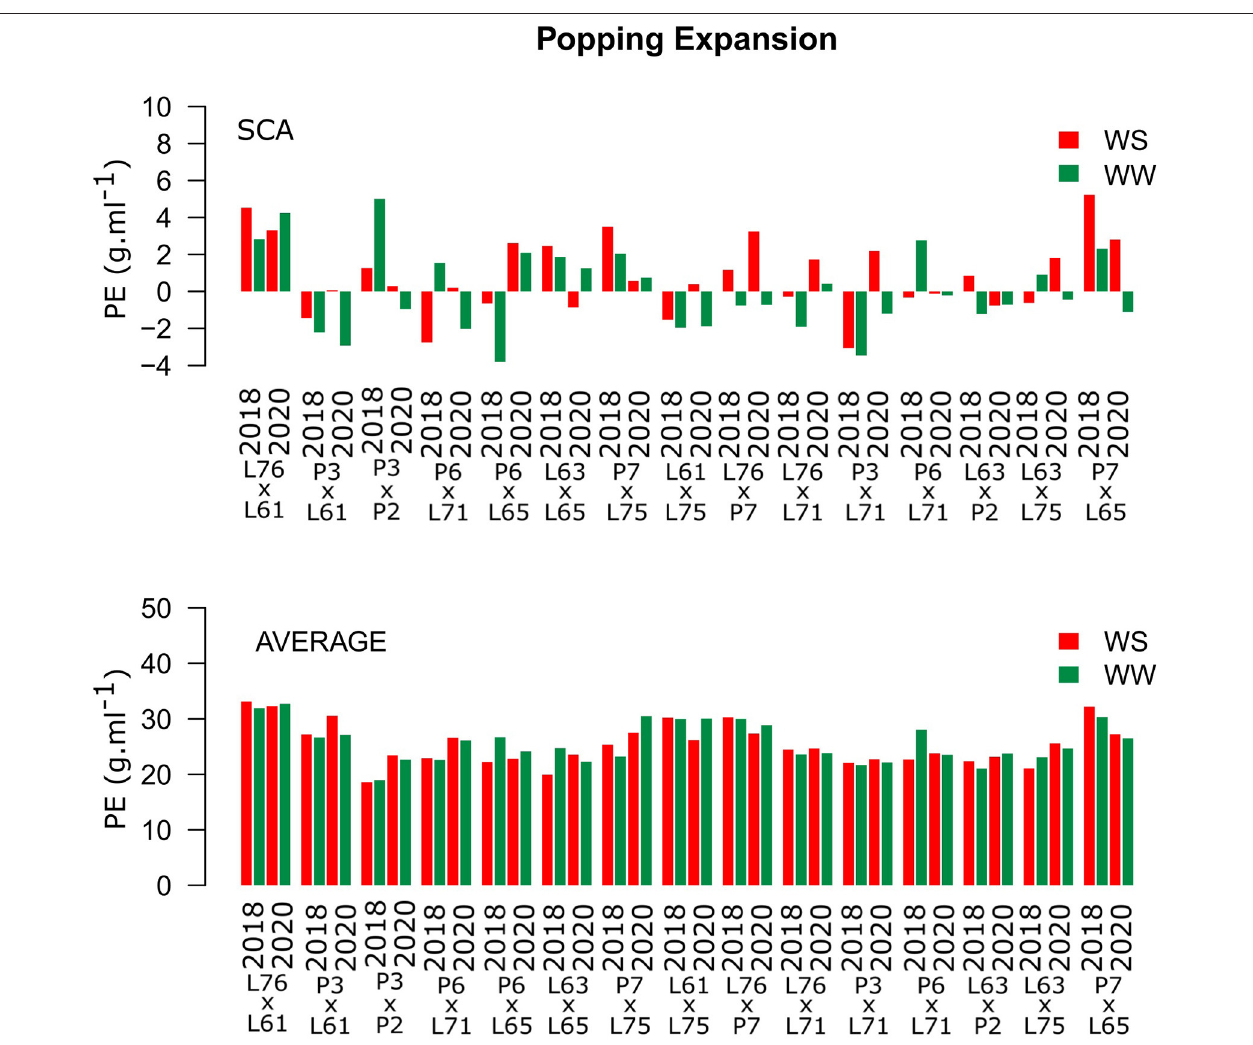
FIGURE 4 | Estimation of the SCA and PE (g ml − 1 ) mean values for popcorn hybrids evaluated under two WCs and crop seasons in 2018 and 2020. WS is represented by red bars and the WW condition is represented by dark-green